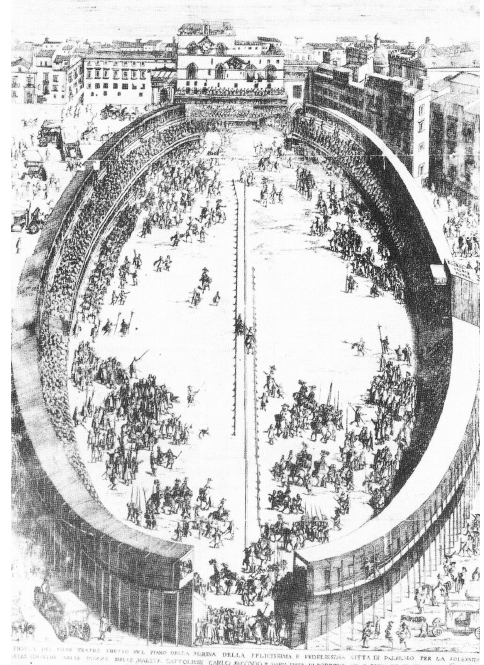
Figure 16. Bull hunting for the Tournament in Plaza Marina in Palermo, 1680 of P. Maggio in Fagiolo M. (Ed.) Le Capitali Della Festa ; Italia Centrale e Meridionale, Roma, Italia [23].